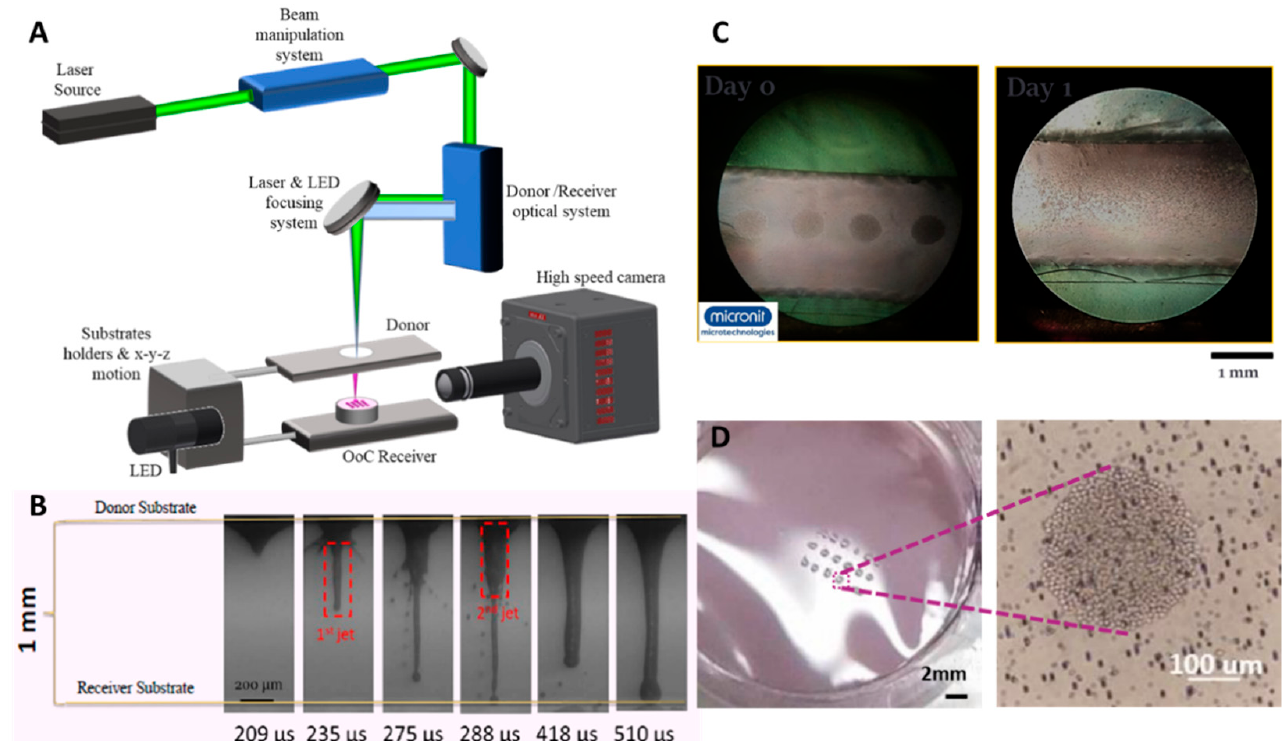
Figure 12. Three-dimensional bioprinting lung cancer cell line inside microfluidic platform for the investigation of possible migrations towards lymph node cells. ( A ) Schematic representation of la- ser-induced forward transfer (LIFT) bioprinting technique for organ-on-chip applications. ( B ) Jet- ting analysis during 3D bioprinting using a high-speed camera analysis. ( C ) Bioprinted LLC cells inside a commercially available microfluidic chip https://www.micronit.com/ (accessed on 7 April 2022). ( D ) Bioprinted LLC cells inside OoC’s chamber. Unpublished data from S. Elezoglou et al.